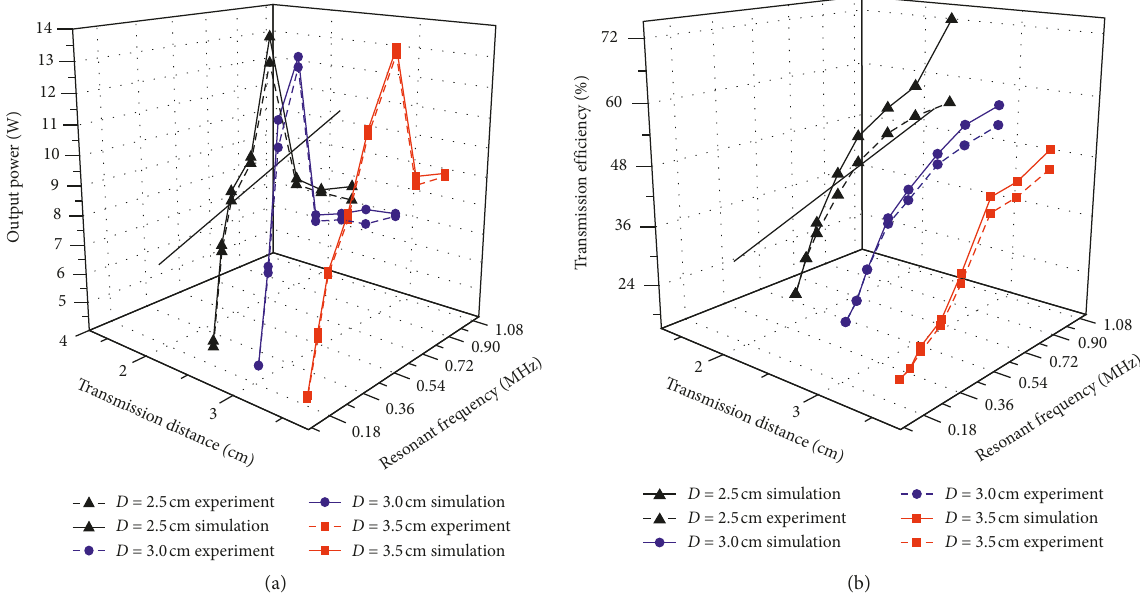
Figure 16: (a) Resonant frequency-output power efficiency relationships; (b) resonant frequency-transmission efficiency